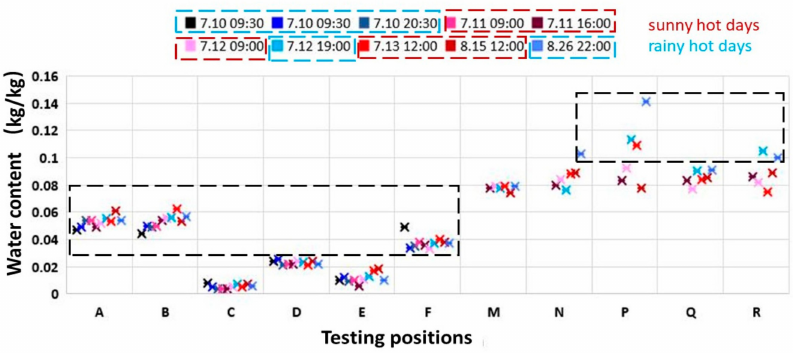
Figure 17. Water content of the measuring